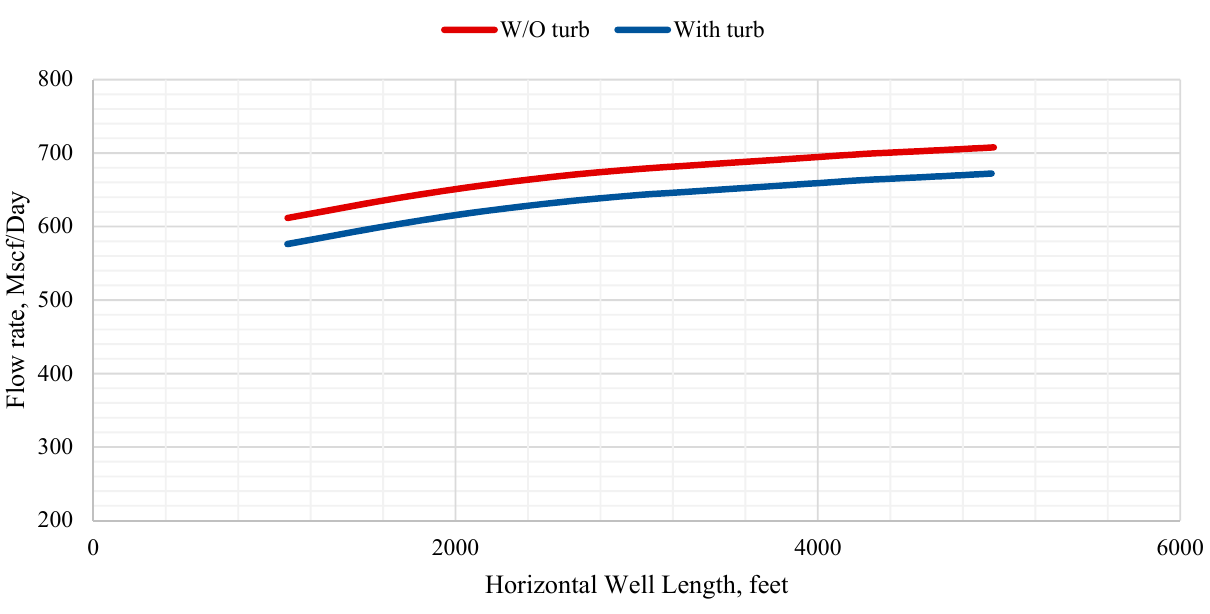
Figure 10. Gas flow rate versus horizontal well length.